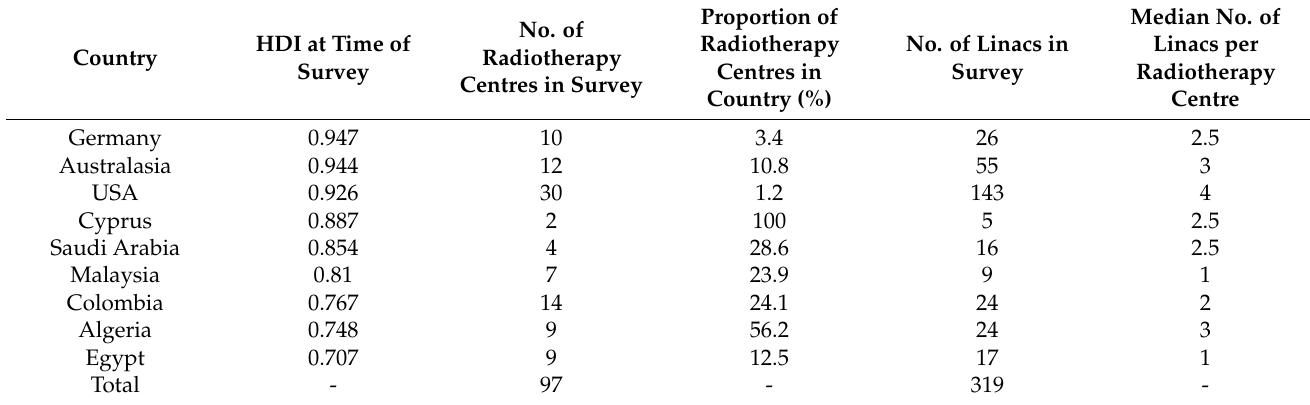
Table 1. Data on radiotherapy centres completing the questionnaire for each country [14].